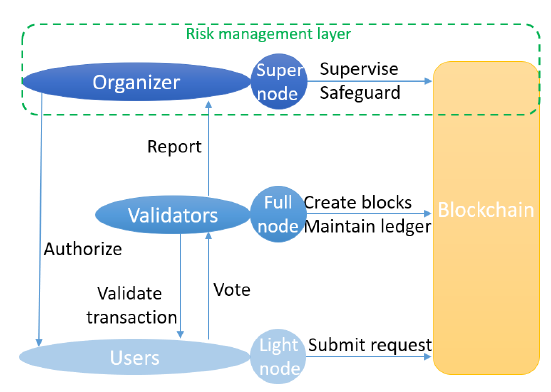
Figure 2. An overview of the organizational